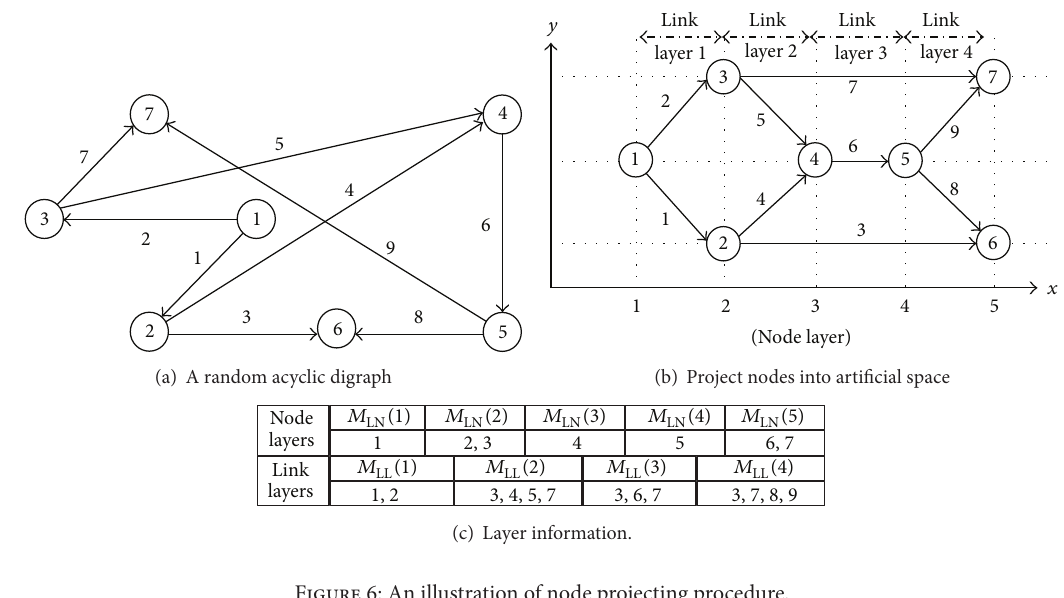
Figure 6: An illustration of node projecting